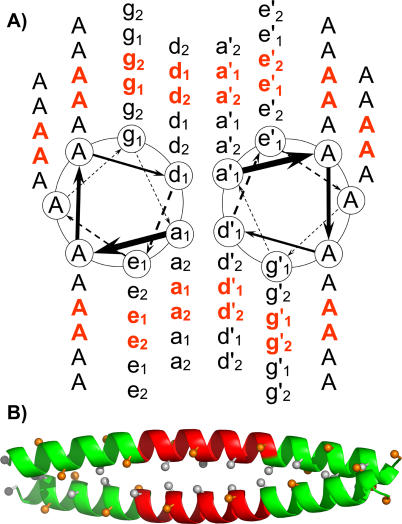
The Unit Cell Used for Modeling Coiled-Coil InteractionsThe entire structure consists of three copies of the sequence of the central unit cell, which is a1AAd1e1Ag1a2AAd2e2Ag2 on the one strand and a′1AAd′1e′1Ag′1a′2AAd′2e′2Ag′2 on the other, marked in red (A = alanine). Only positions a, d, e, and g were allowed to vary. The energy of the central unit cell was calculated as the sum of its internal interactions and half of its interactions with the bounding structure.(A) Helical-wheel diagram corresponding to the entire structure modeled, with sites in the central unit cell colored red.(B) Ribbon diagram representation of the modeled system viewed as in Figure 2B with the central unit cell colored red. Grey and orange balls represent locations of side-chain Cβ atoms of a/d and e/g sites, respectively.